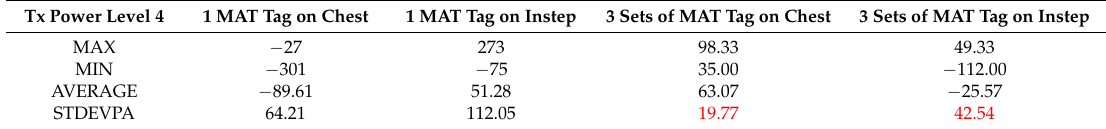
Table 13. Comparison between one MAT and three sets of